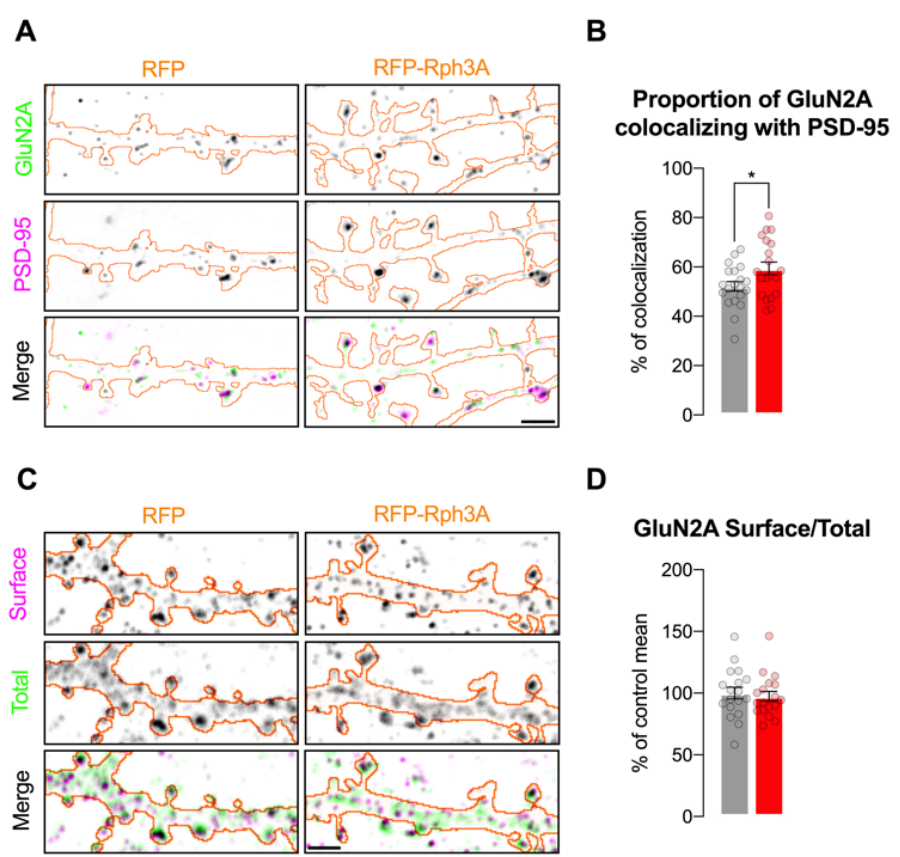
Figure 4. Rph3A overexpression is sufficient for synaptic and surface stabilization of GluN2A-containing NMDARs. ( A ): Airyscan confocal images of GluN2A (green) and PSD-95 (magenta) staining in RFP ( left ) or RFP-Rph3A ( right ) transfected neurons (orange outline). Scale bar: 2 µ m. ( B ): Bar graph representing mean ± SEM of percentage of GluN2A colocalizing with PSD-95, unpaired t -test. ( C ): Confocal images of surface (magenta) and total GluN2A (green) staining in RFP (left) or RFP-Rph3A (right) transfected neurons (orange outline). Scale bar: 2 µ m. ( D ): Bar graph representing mean ± SEM of percentage of control mean of GluN2A surface/total ratio, Mann–Whitney U test. * p < 0.05. Dots represent single values. Conversely, the overall surface/total ratio of GluN2A staining along dendrites in Rph3A overexpressing neurons analyzed with confocal microscopy did not